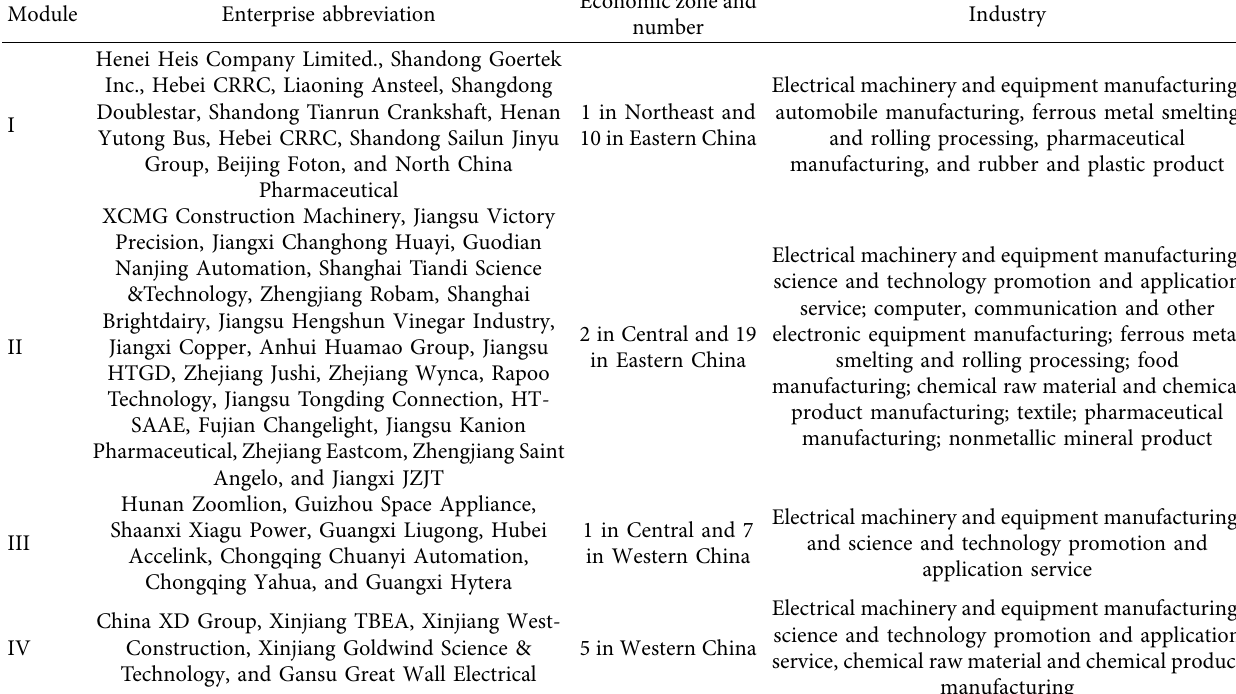
Table 4: Module members and industries.